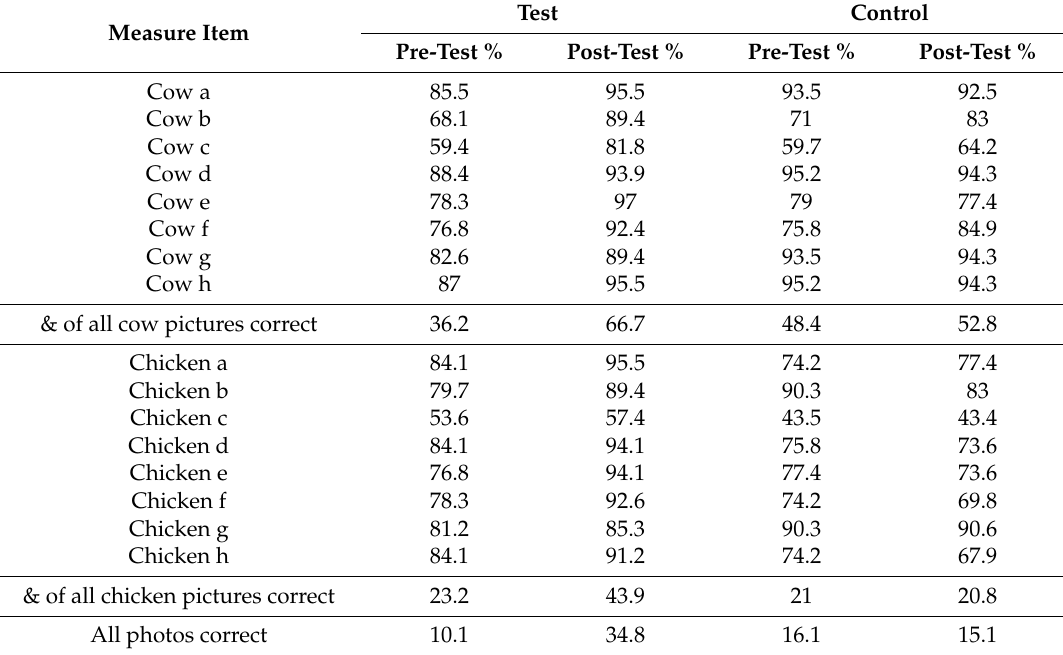
Table 8. Descriptive statistics for knowledge about animal welfare in photos of farming